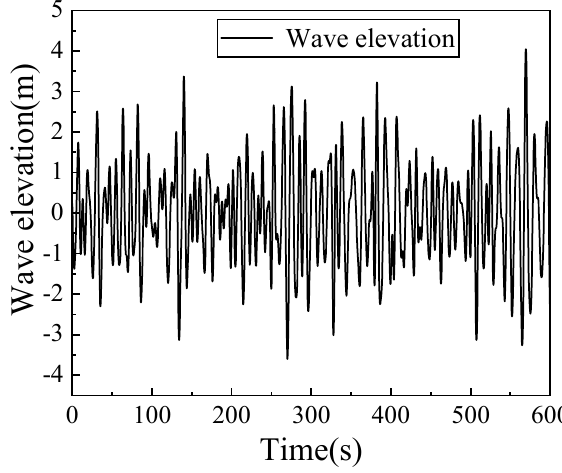
Figure 6. PM spectral wave height.